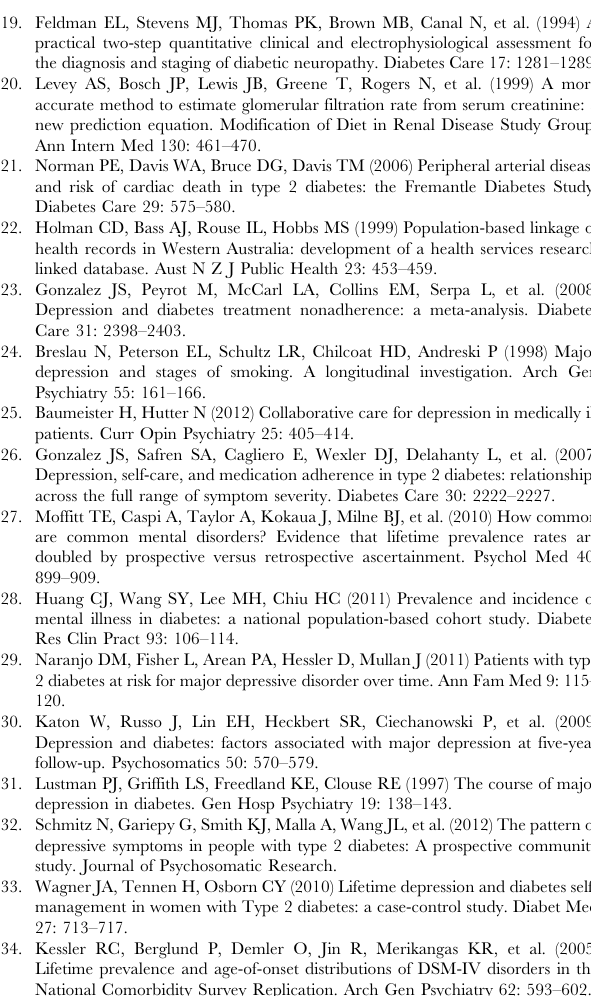
Table S1 Brief Life-time Depression Scale that